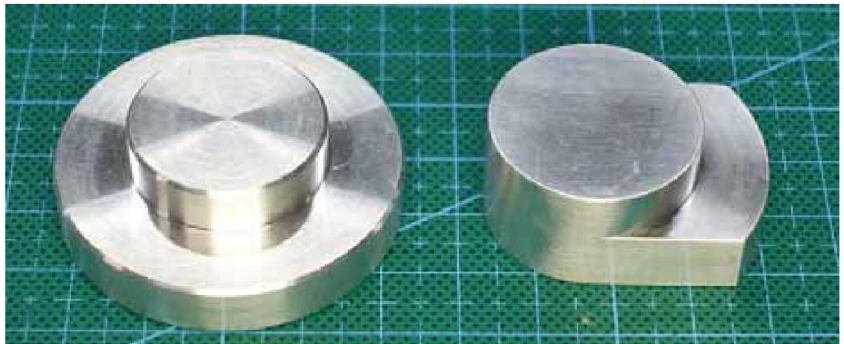
Figure 3. Prototype probes.